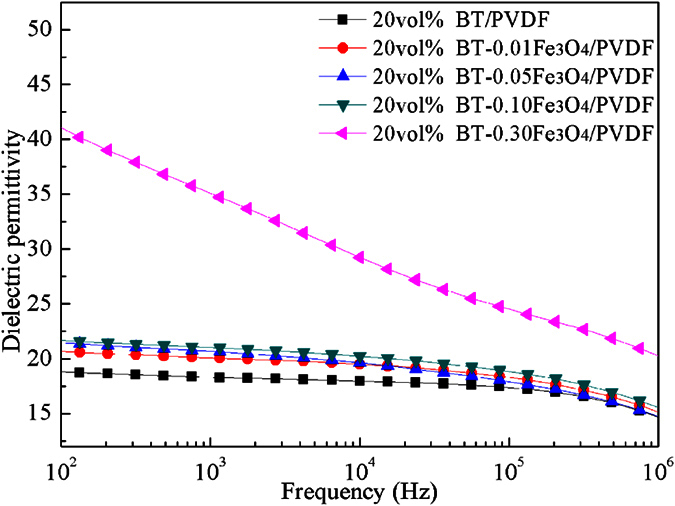
Dependence of dielectric permittivity on frequency of the 20 vol.% BT–xFe3O4/PVDF composites at room temperature.